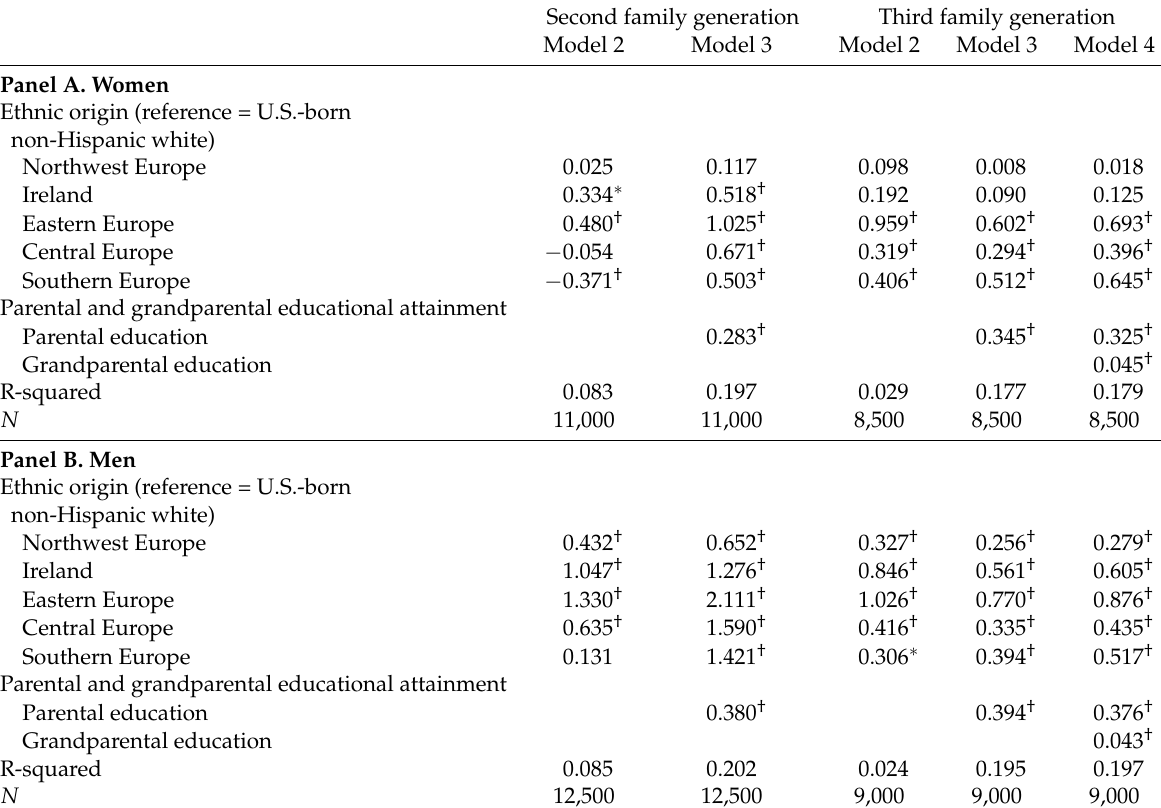
Table 3: Educational mobility among second and third family generation women and men (ordinary least squares regression